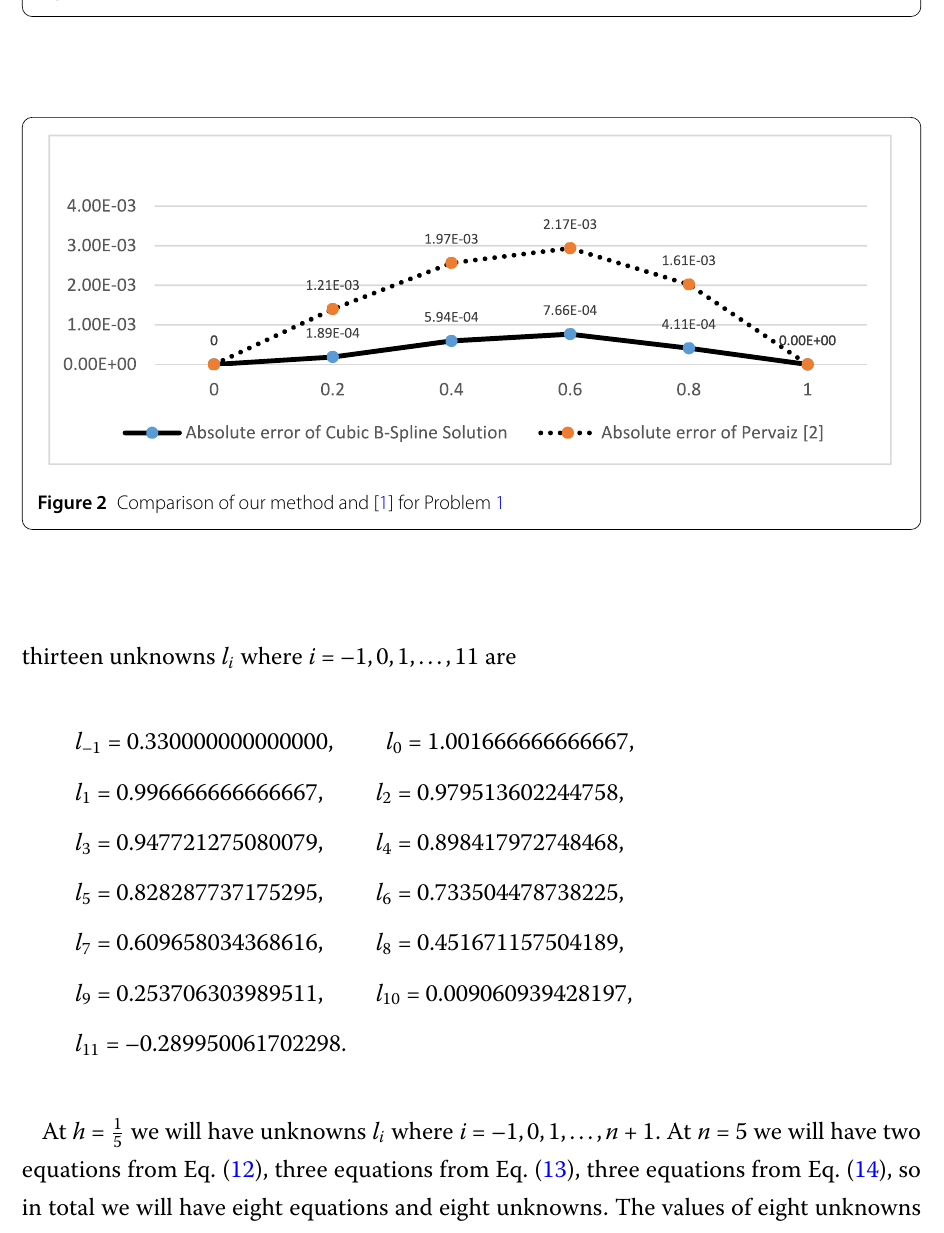
Figure 1 Comparison of our method and [24] and [30] for Problem 1